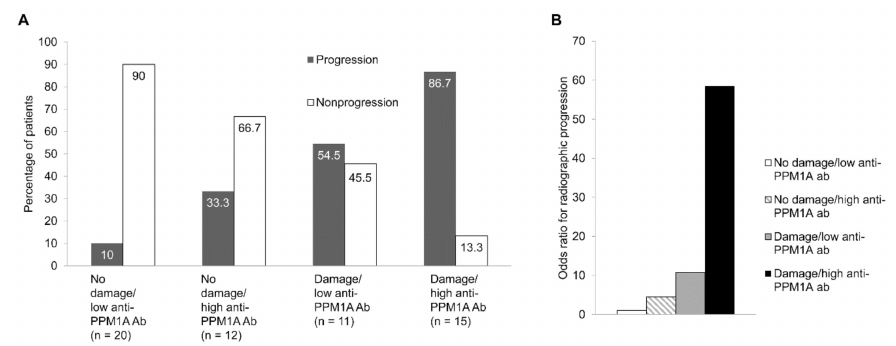
Figure 3. ( A ) Frequency of radiographic progression, ( B ) odds ratio for radiographic progression categorized according to anti-PPM1A antibodies and mSASSS at baseline. Damage and high anti-PPM1A antibodies were defined as mSASSS ≥ 13 units and anti-PPM1A antibodies ≥ 43.77 ng / mL, respectively. PPM1A: Protein